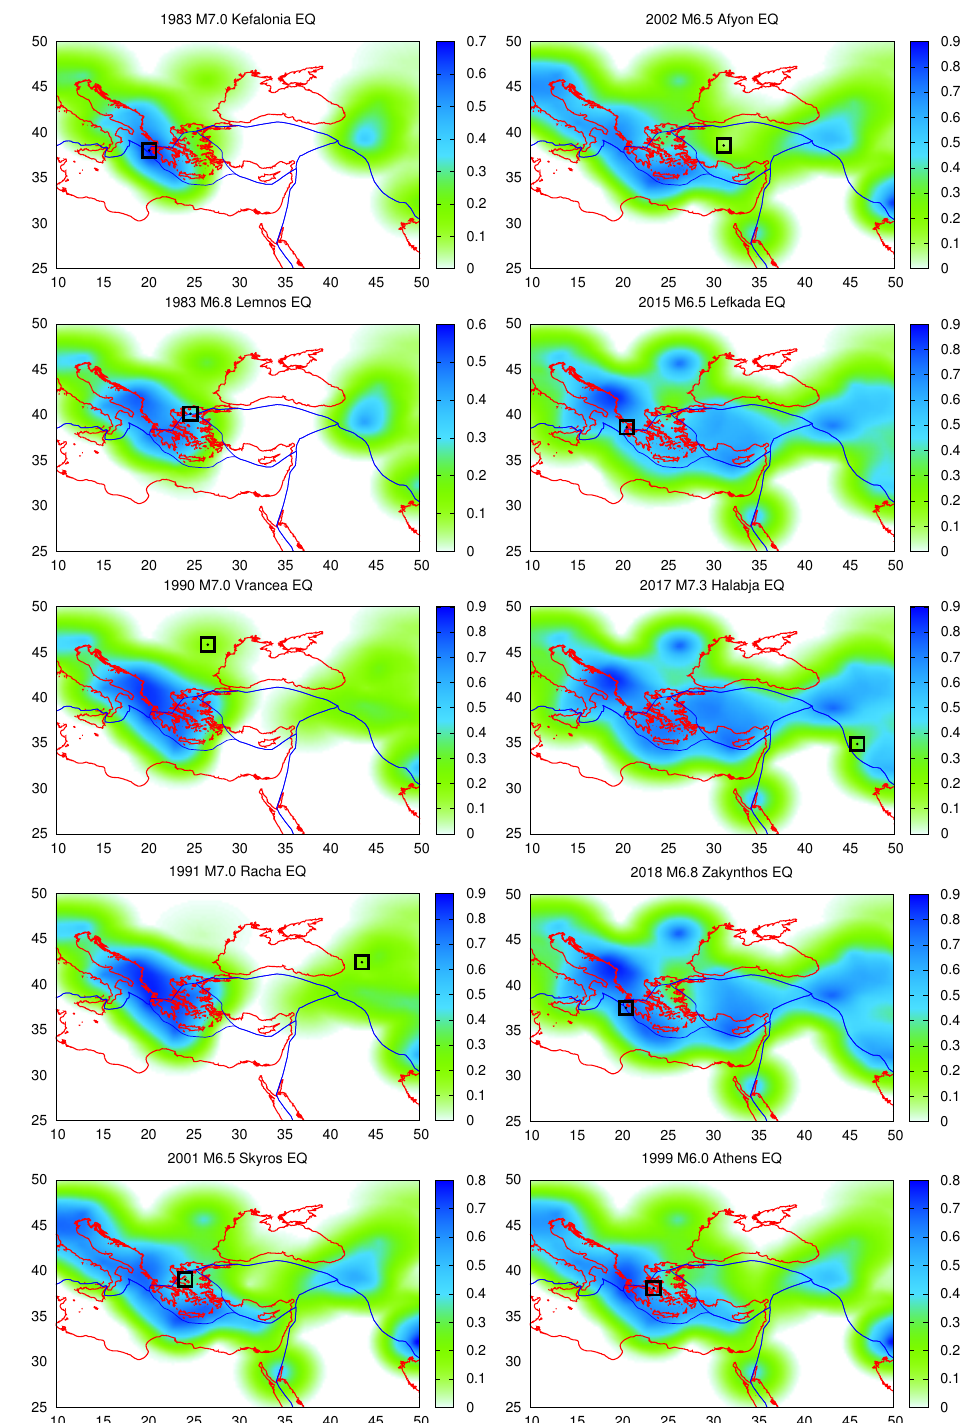
Figure 6. Same as Figure 4, but here, the (cid:104) EPS (cid:105) was calculated at the time of the β 120 minimum reported in Tables 2 and 3 of [115] for all ‘false alarms’ preceding the strong M ≥ 6.5 EQs within the area A 5 . The EPS evaluated (at the time of the local minimum of β 80 ) on 3 September 1999 before the deadly M6.0 Athens EQ is also shown; see Figure 2. Note that, although a strong EQ activity was evolving at Izmit at that time, a strong EQ struck the Greek